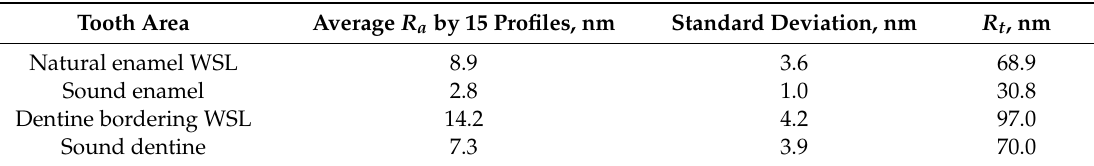
Table 3. Surface roughness of the tooth